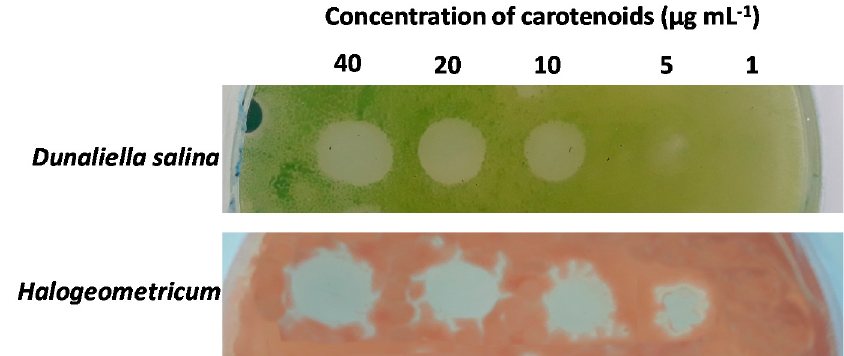
Figure 5. Minimal Inhibitory Concentration plate assay. Dilutions of the active extracts were assayed against one of the most susceptible microorganisms of each group. Halophilic microorganisms, represented by Dunaliella salina and Halogeometricum, showed to be more sensitive to the extracts.